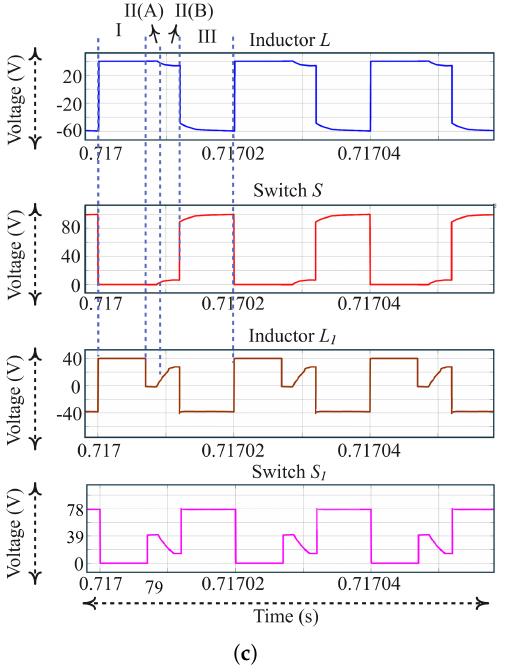
Figure 19. Simulation results when L > L 1 and L = L 2 = L 3 ... L n , ( a ) v in , i in , v out , and i out , ( b ) i L , i L 1 , i L 2 , and i L 3 , ( c ) v L , v S , v L 1 , and v S 1